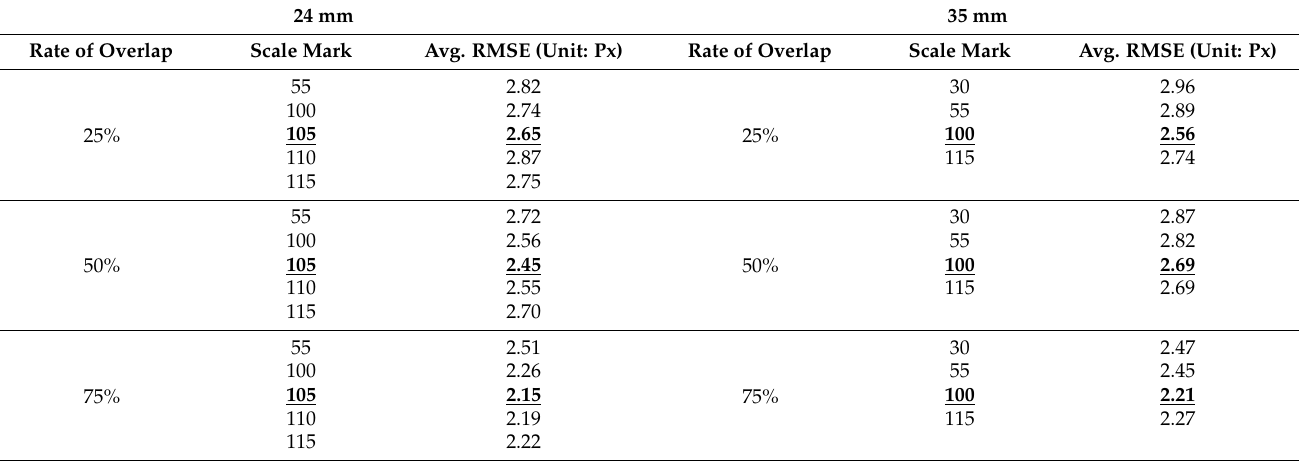
Table 2. Quality analysis with different rate of overlap and scale marks (bold indicates the suggested scale